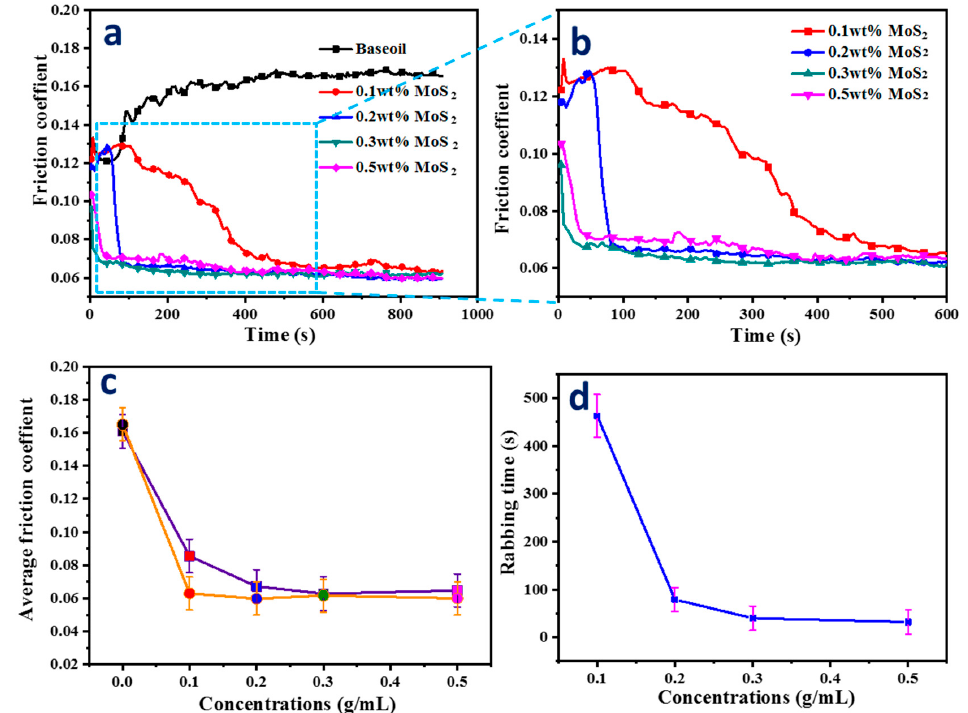
Figure 3. ( a ) Tribological tests results of paraffin oils with different additive amounts of MoS 2 QDs; ( b ) coefficient of friction (COF) for different additive amounts of MoS 2 QDs; ( c ) average COF and COF in steady state after rubbing; ( d ) the change in rubbing time at different concentrations.